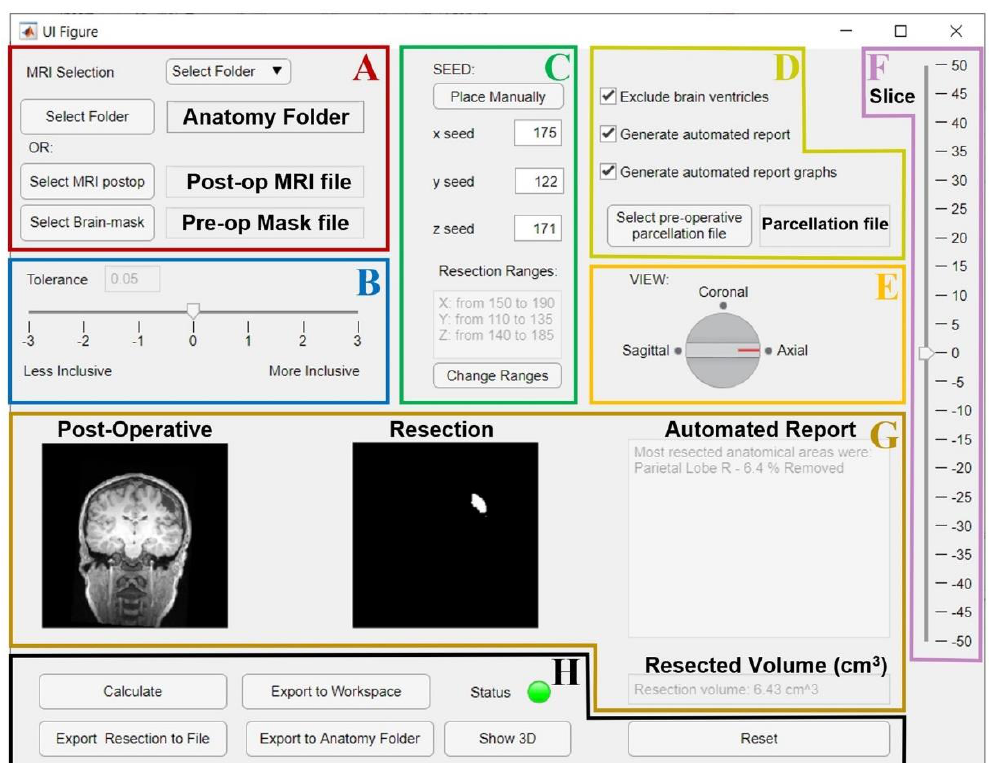
Figure 7. GUI for the resection segmentation. ( A ): Interface to select postoperative MRI and preoperative brain-mask files, or the patient’s Brainstorm anatomy folder that contains them. ( B ): Slider to select tolerance threshold (default: optimal value). ( C ): Interface to place the initial seed using an MRI viewer (see Figure 8) or entering its coordinates. The user can set an additional ROI for region growing by entering its ranges (this is optional, see Figure 8). ( D ): Options to exclude brain ventricles and/or generate the anatomical report through a brain parcellation file, which must be selected. E and F: the user can change the view ( E ) and slice ( F ) to visualize the postoperative MRI and resection model shown in G. ( G ): Preview of results (left: postoperative MRI; middle: resection model, right: automated report and resection volume in cm 3 ). ( H ): Buttons to run the segmentation (“Calculate”), or to export results to a file (NIfTI), MATLAB workspace, or directly to the initial Brainstorm anatomy folder. Status LED turns red in case of error (green otherwise). “Show 3D” button shows the resection model (see Figure 8), while “Reset” allows to reset all settings and run again.